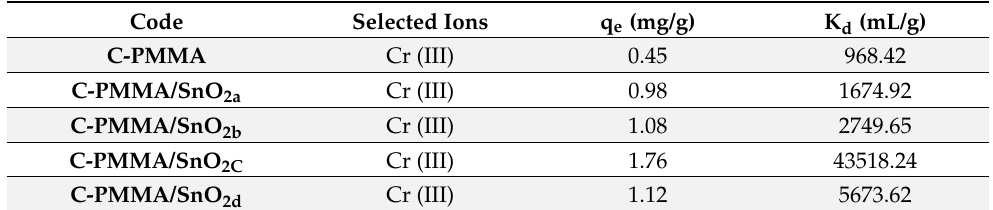
Table 3. The adsorption studies of pure C-PMMA and C-PMMA/SnO 2(a–d) for chromium (III) ions at 25 ◦